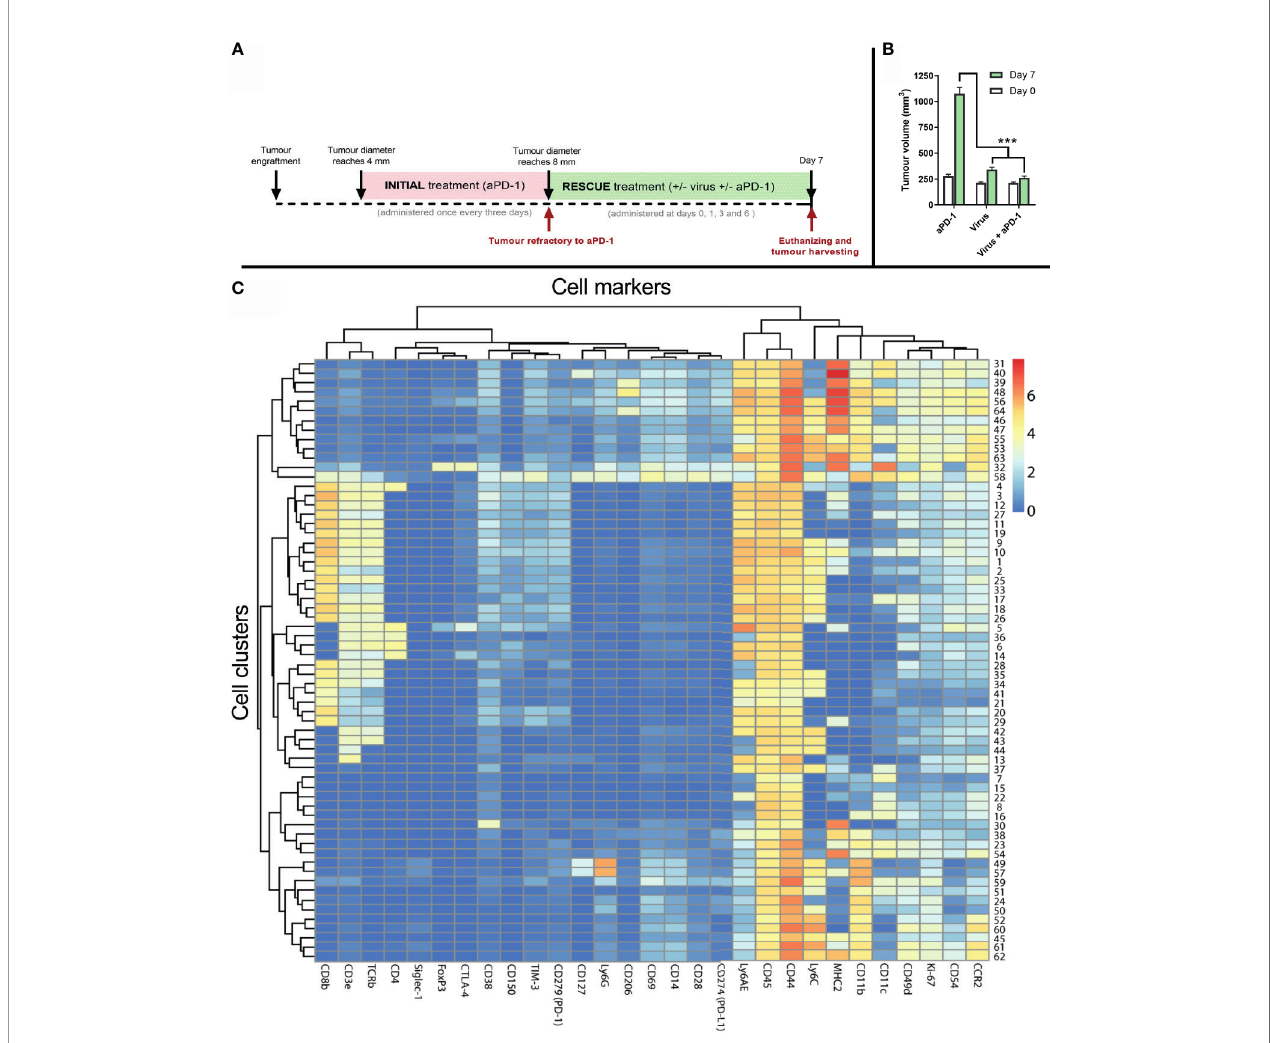
FIGURE 4 | Tumor samples and analysis to study mechanism of action of the treatments. (A) Experimental design: 27 mice carrying B16.OVA tumors were treated with aPD-1 until they became refractory to the drug as described previously. Subsequently, those animals were assigned to groups where animals were treated with the same aPD-1 regimen (n=9), with 1x108 VP intratumorally once every three days (n=9), or both (n= 9). Four rounds of treatments were given at days 0, 1, 3 and 6 after they were considered refractory and sacri fi ced at day 7 for tumor collection. (B) Average tumor volumes (and SEM) at day 0 (when they quali fi ed as refractory) and day 7 (when tumors were harvested). (C) Heatmap after the analysis of tumors by CyTOF and subsequent processing of the data by FLOWSOM providing 64 different cell clusters for immune (CD45+) cells. (Mann Whitney test; ***p <